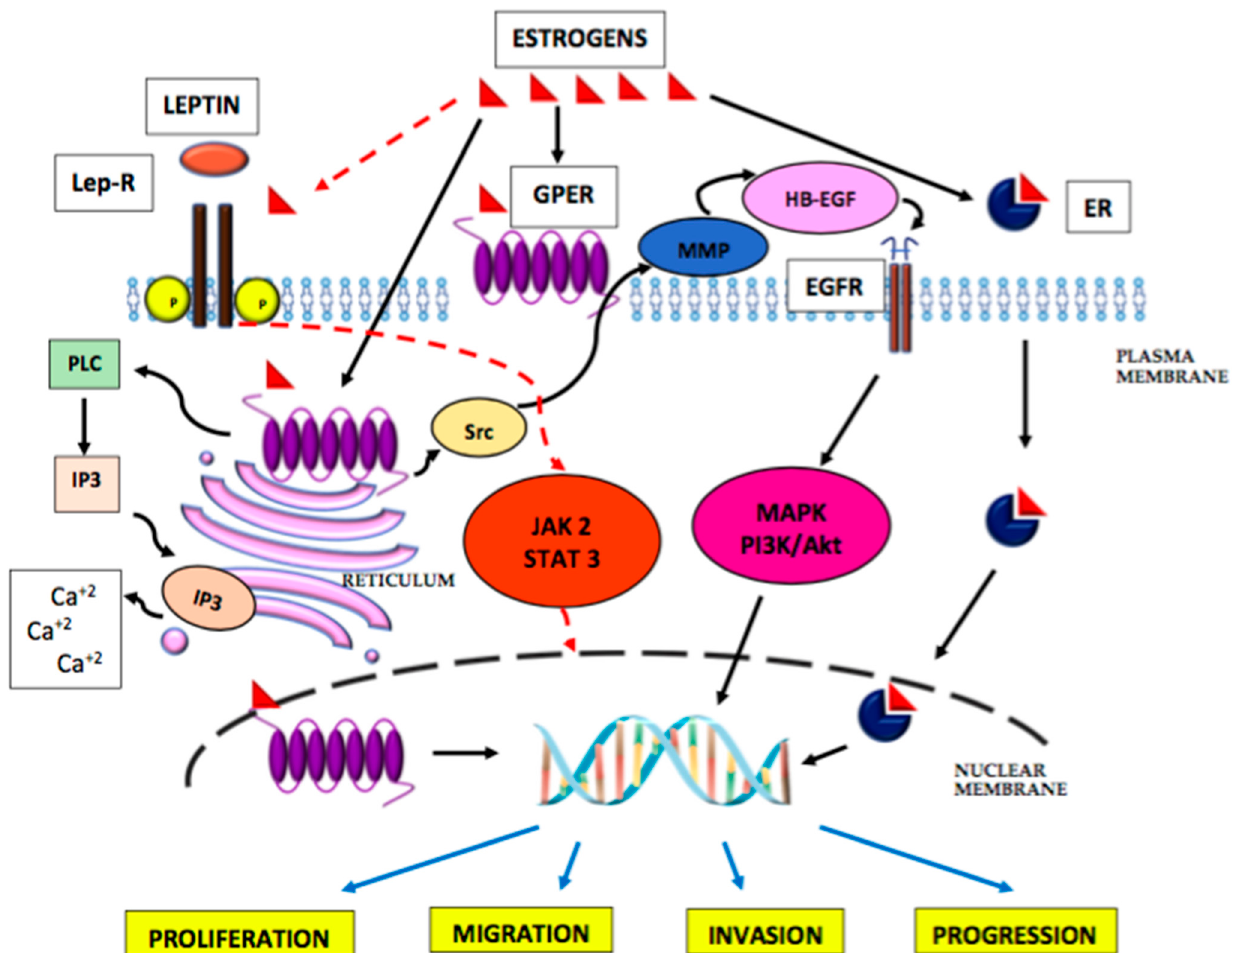
Figure 2. Interaction of oestrogens and leptin and their downstream signalling pathways in endome- trial cancer. JAK—Janus kinase; STAT3—signal transducer and activator of transcription; P13K/Akt— phosphatidylinositol 3-kinase/protein kinase B; Lep-R—leptin receptor; ER—oestrogen receptors; GPER—G-protein-blinded oestrogen receptor; EGFR—epidermal growth factor receptor; MMP— metalloproteinase; P—phosphorylation; IP3—inositol 1,4,5-trisphosphate; PLC—phospholipase C; Src—protein tyrosine kinase.